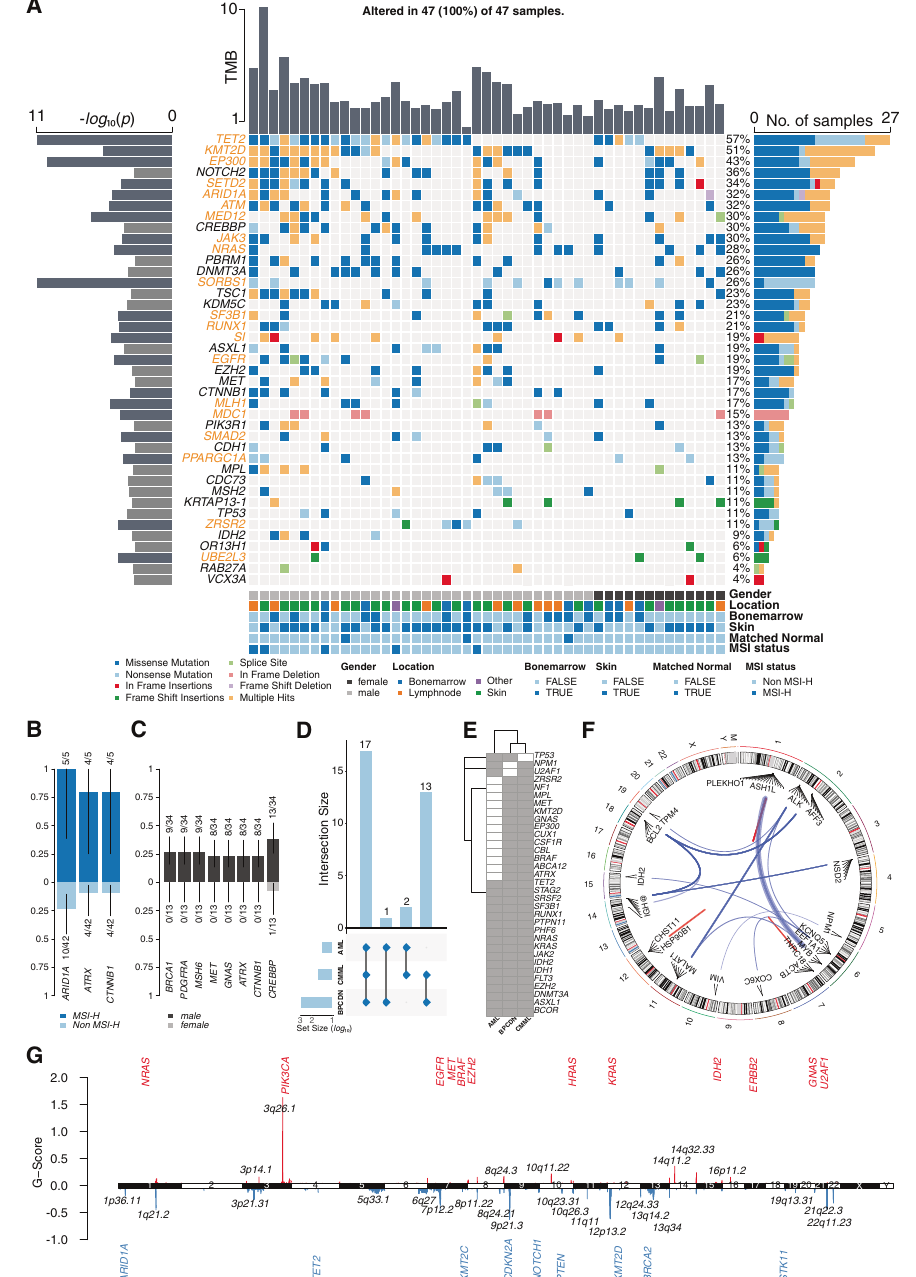
Fig. 1 Molecular landscape in BPDCN. A Oncoplot showing potential driver genes inferred by MUTSIGCV with tumor mutational burden (TMB; upper bar plot), − log 10 -transformed p values (left bar; orange gene names q < 0.1, black gene names p < 0.001) and number of affected samples (right bar). In total 13,908 presumably deleterious mutations, affecting 4507 genes were observed. SNVs and indels comprised 39.8% of these mutations (5532), of which 4524 were missense (81.8%), 289 nonsense (5.2%) and 468 indel mutations (8.5%). Mutation types are color-coded, and covariates are shown below for each sample (covariate “ Other ” refers to samples with tissue affected other than skin or bone marrow). Genes signi fi cantly enriched in MSI-H samples ( B ) and with a male mutation bias ( C ); the number of affected samples and the total number of samples are given and the scale on the y -axis denotes the proportion of mutated samples. D UpSet plot showing the overlap between BPDCN samples ( n = 47, this study, MUTSIGCV genes selected), CMML ( n = 76, Tyner et al.) and AML ( n = 672, Tyner et al.) for genes mutated in at least two samples per data set (only overlapping genes are shown); E overlapping genes between the three data sets for genes mutated in at least two entities; F known cancer and MYB fusion identi fi ed in BPDCN samples with respect to their genomic location; red links indicate intra-chromosomal fusions, blue links indicate inter-chromosomal fusions, respectively. Link width correlates with the number of reads supporting the fusion event; G location of SCNAs along the genome and GISTIC G-scores (G = Frequency × Amplitude; red bars denote gains and blue bars losses; gene names refer to affected oncogenes and tumor-suppressor genes within identi fi ed